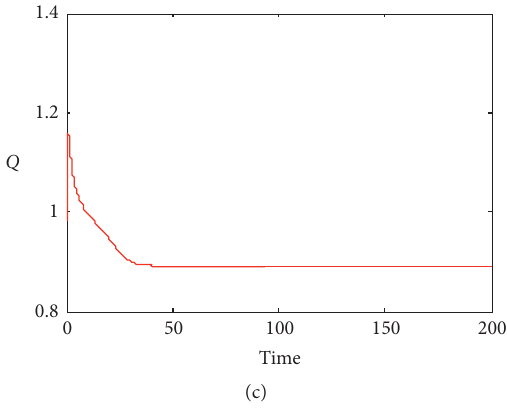
Figure 7: Implementation of Z-control.